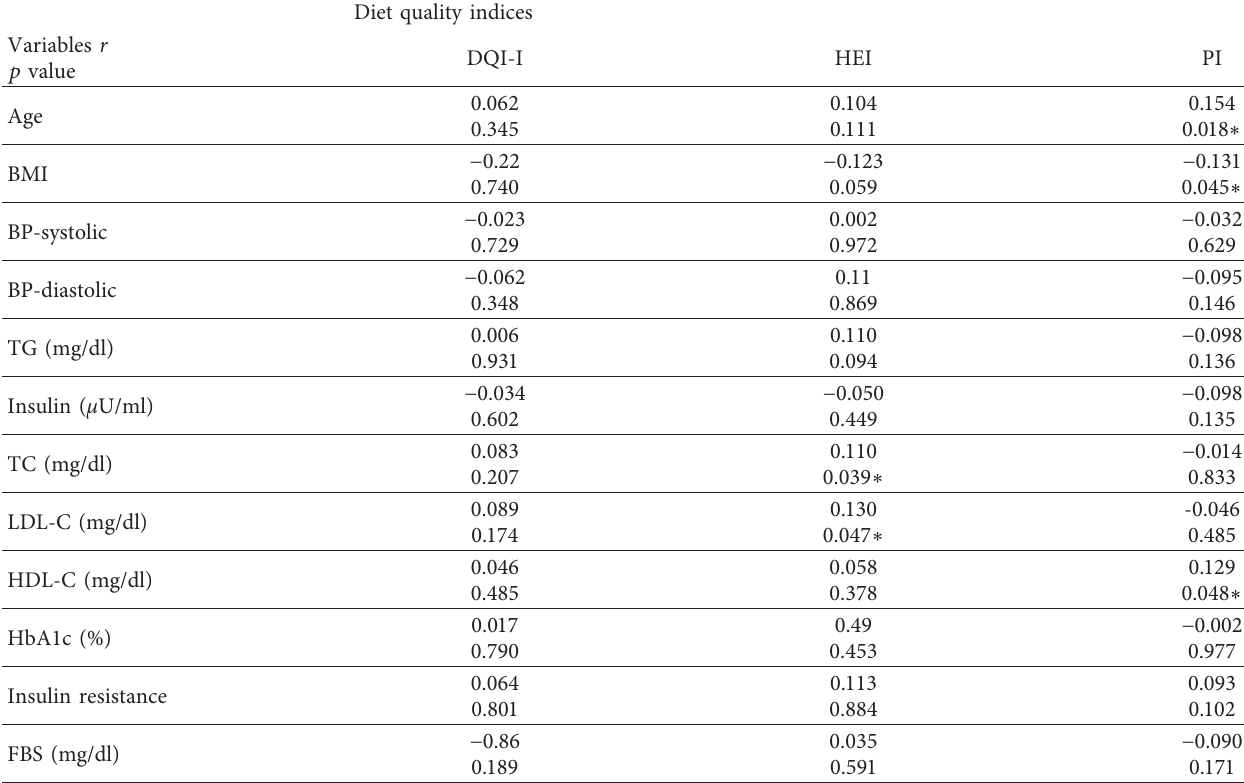
Table 2: Correlation ( r , p value) between age, BMI, and clinical/biochemical variables and three diet quality indices. Diet quality